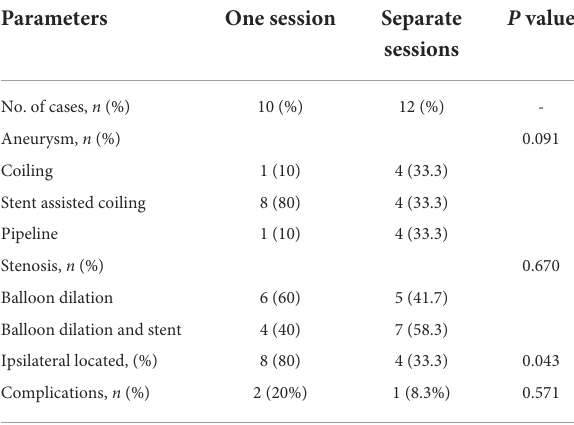
TABLE 3 Comparison of treatment details between